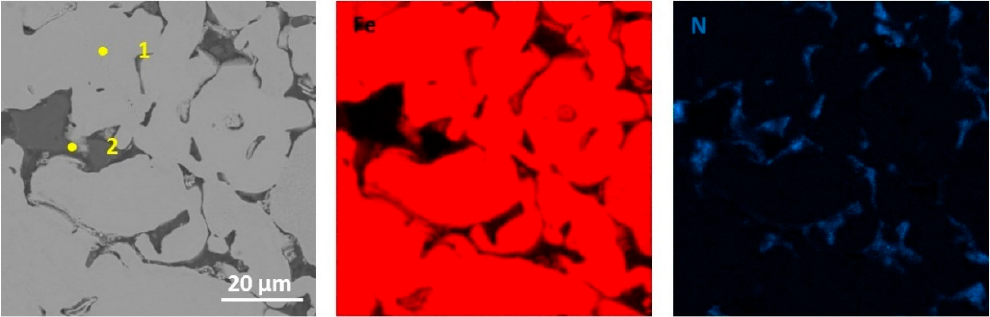
Figure 12. EDS mapping of sintered Fe with the addition of MoS 2 with a size of 1.5 µ m (for pressing pressure 250 MPa).